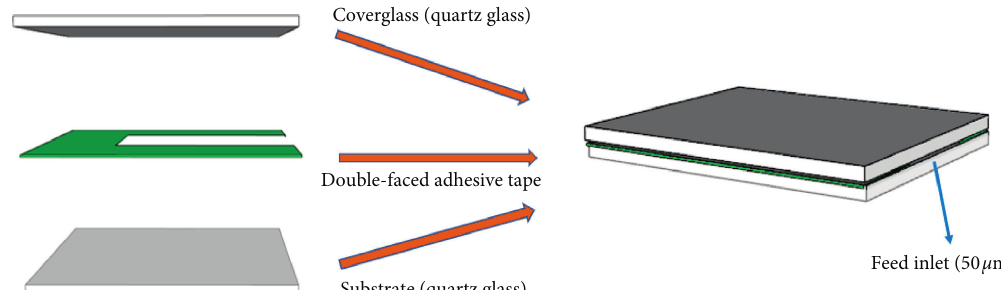
Figure 2: Schematic of microfluidic chip